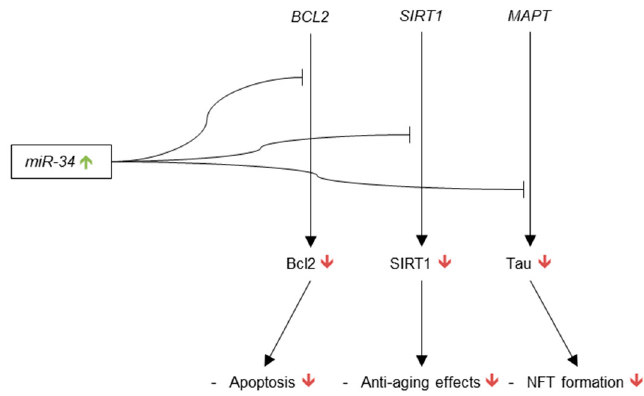
Figure 5. Regulation by miR-34. miR-34 inhibits the translation of BCL2, SIRT1, and Tau. The green arrow indicates the increased expression levels of miR-34 in AD brain. The red arrows indicate the hypothetically decreased levels of the targeted proteins and their cellular effects.